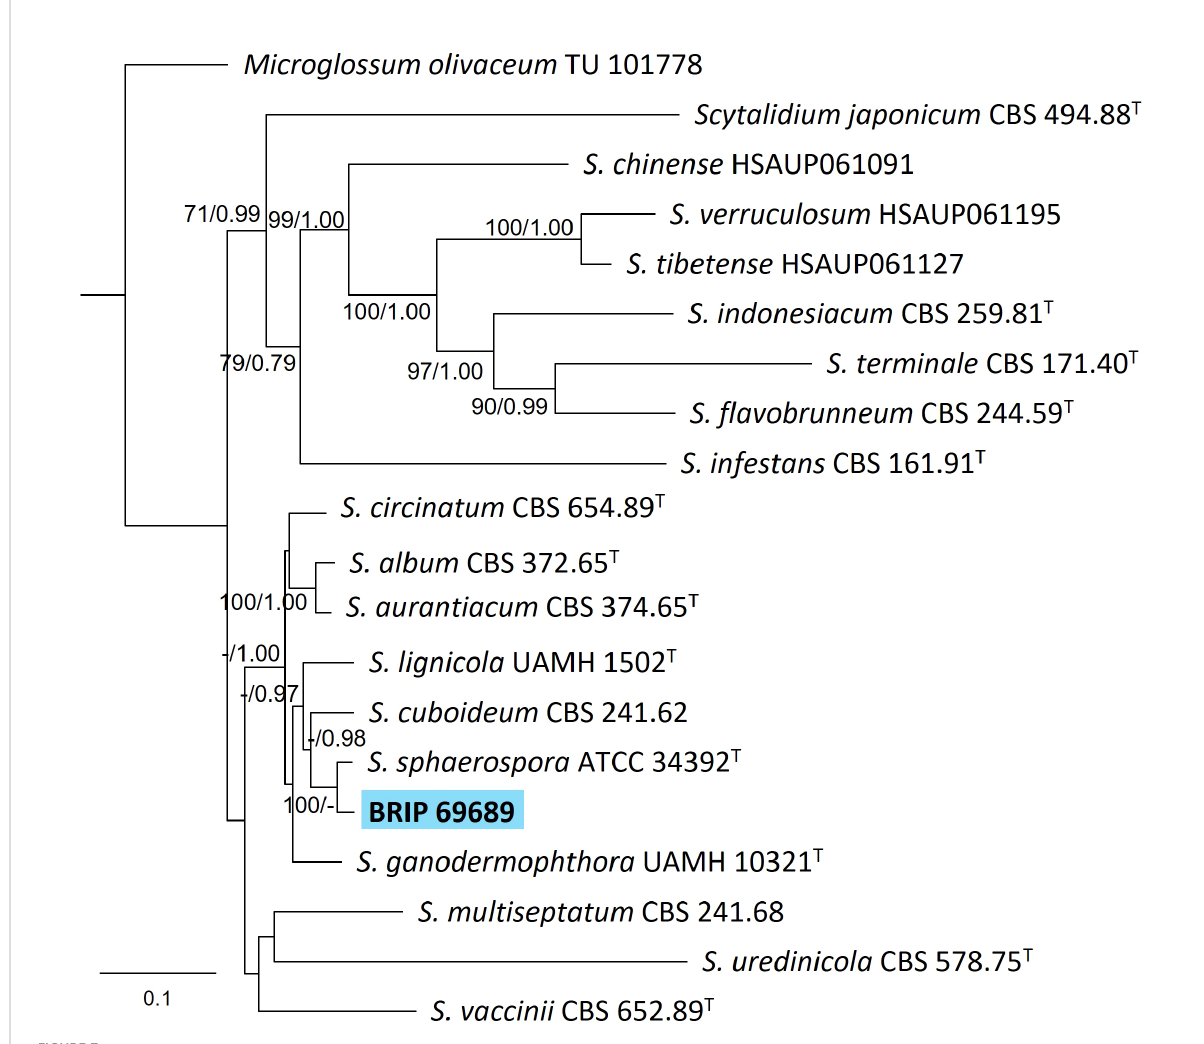
FIGURE 7 Phylogenetic tree inferred from a RAxML analysis based on a concatenated alignment of ITS, LSU, rpb2 and SSU sequences of related genera from Scytalidium (Helotiales). RAxML bootstrap (bs) values greater than 70% and Bayesian posterior probabilities (pp) greater than 0.8 are given at the nodes (bs/pp). In bold font is the isolate from this study, and ex-type strains are indicated with T